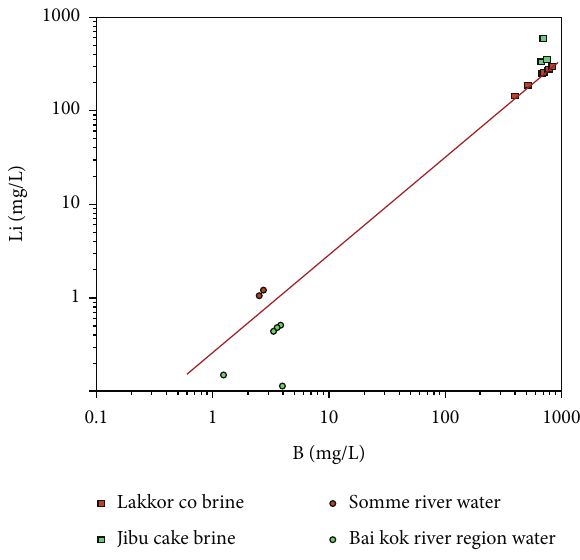
Figure 7: Boron-lithium elemental ratio